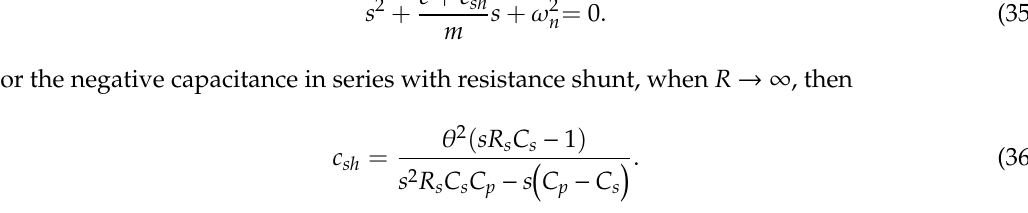
Figure 8. Controlled sti ff ness analysis for the negative inductance / negative capacitance in series with Figure 8 . Controlled stiffness analysis for the negative inductance/negative capacitance in series with R s R s shunt.